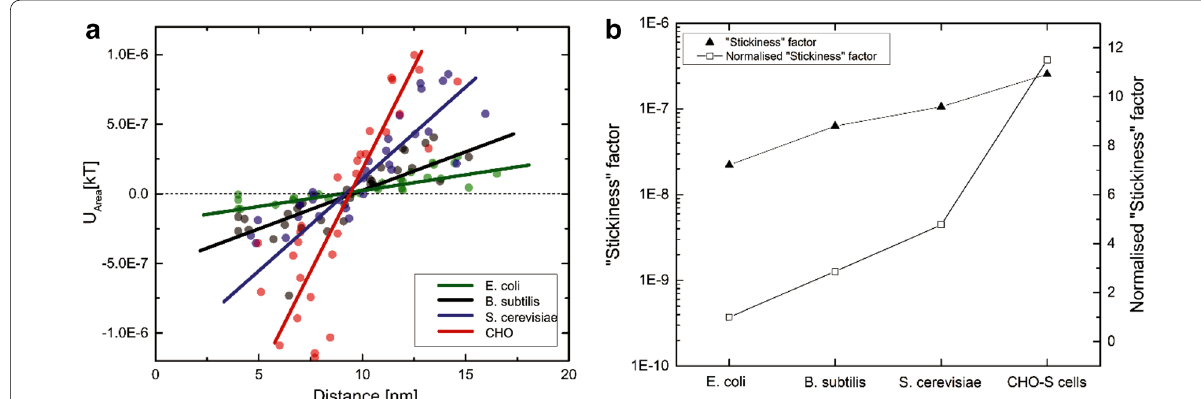
Fig. 4 a A combined interaction energy Vs distance plot for E. coli , B. subtilis , S. cerevisiae and CHO cells as function of distance in 20 mM phosphate buffer at pH 7.4; b absolute values of “Stickiness” factor compared with normalized